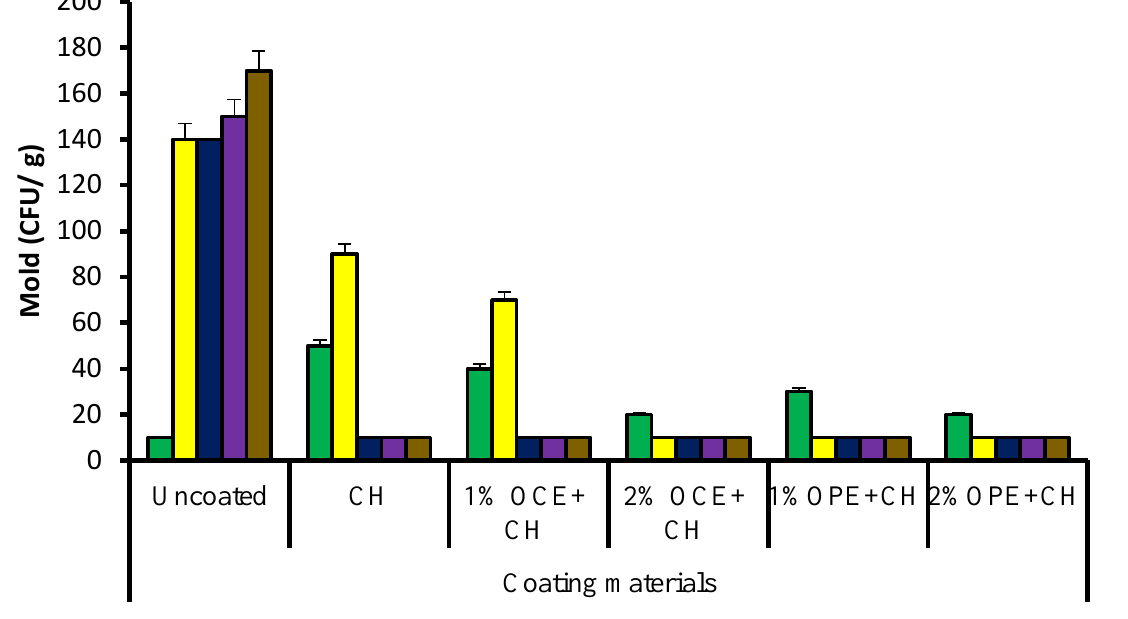
Figure 1. Mold (CFU/g) of fresh Barhi dates coated with chitosan and/or olive cake or orange peel extracts during cold storage (4 °C). CH, Chitosan; OCE, Olive cake extract; OPE, Orange peel extract. Columns from left to right (storage period, days), 0 (green), 7 (yellow), 14 (blue), 21 (purple), and 28 (brown).